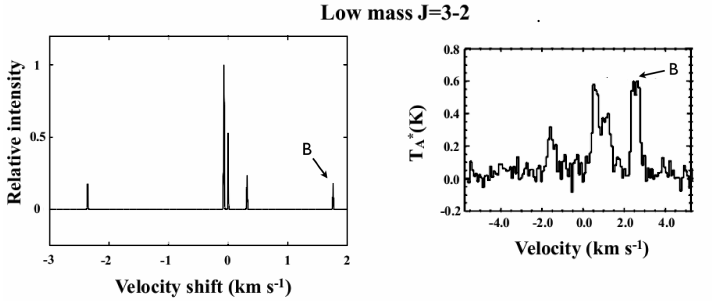
Fig. 2. Optically thin HCN J=3 ! 2 (left panel) compared with a JCMT observation of L 1622A-2 (right